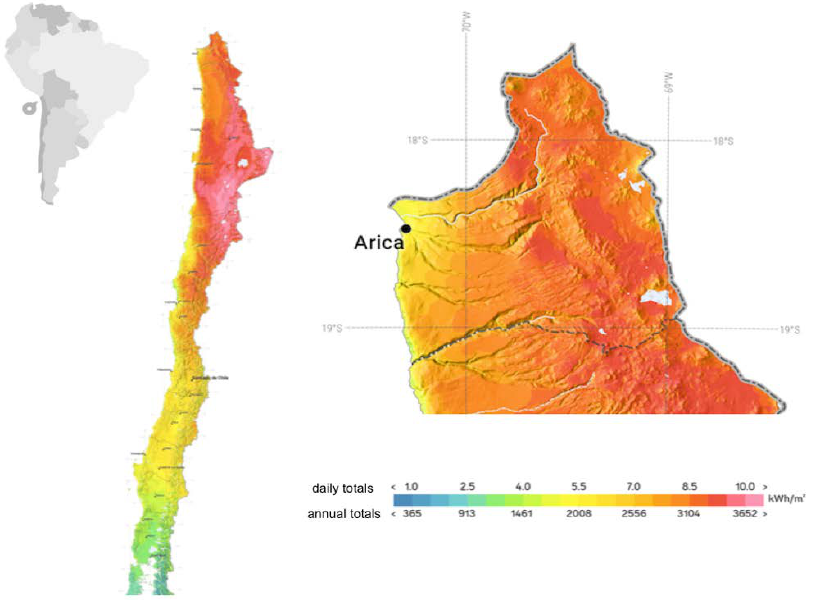
Figure 2. Solar resource map, normal direct irradiation in the Arica and Parinacota Region (source: Solargis, 2019) [26].